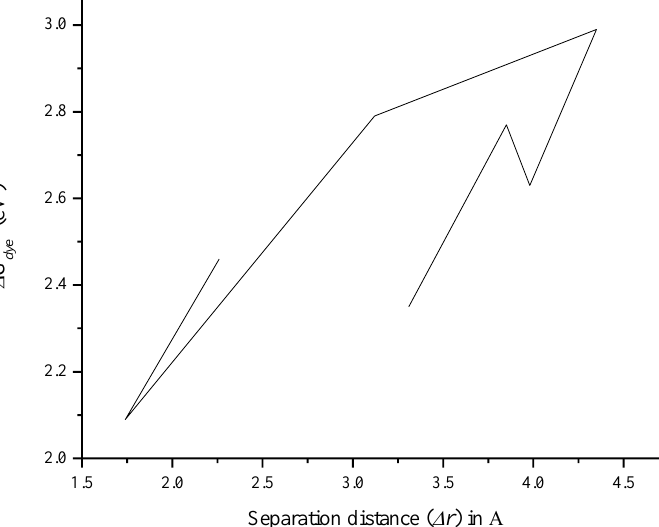
Figure 11. Graphical relationship between electron − hole separation distance and incident photon transfer efficiency.